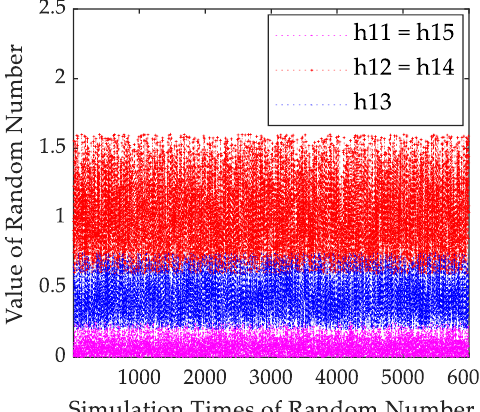
Figure 10. RCS model.